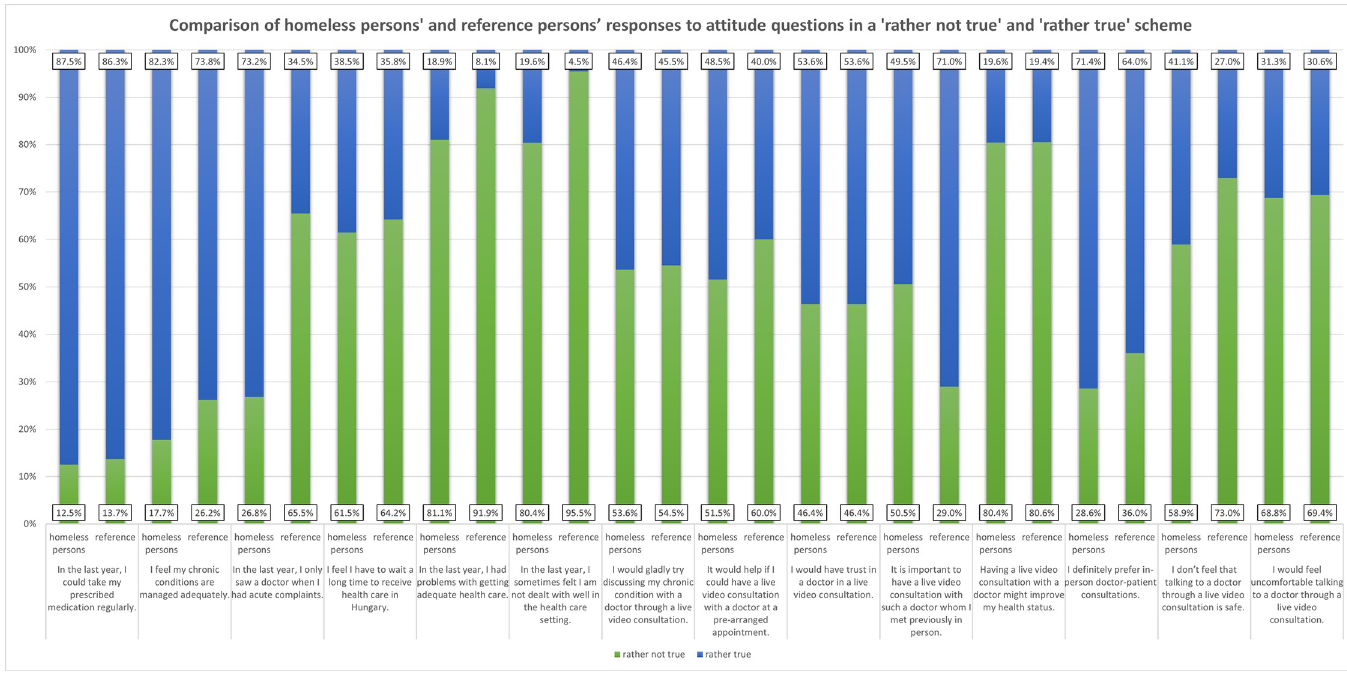
Fig 1. Comparison of homeless persons’ and reference persons’ responses to attitude questions in a ’rather not true’ and ’rather true’ scheme.